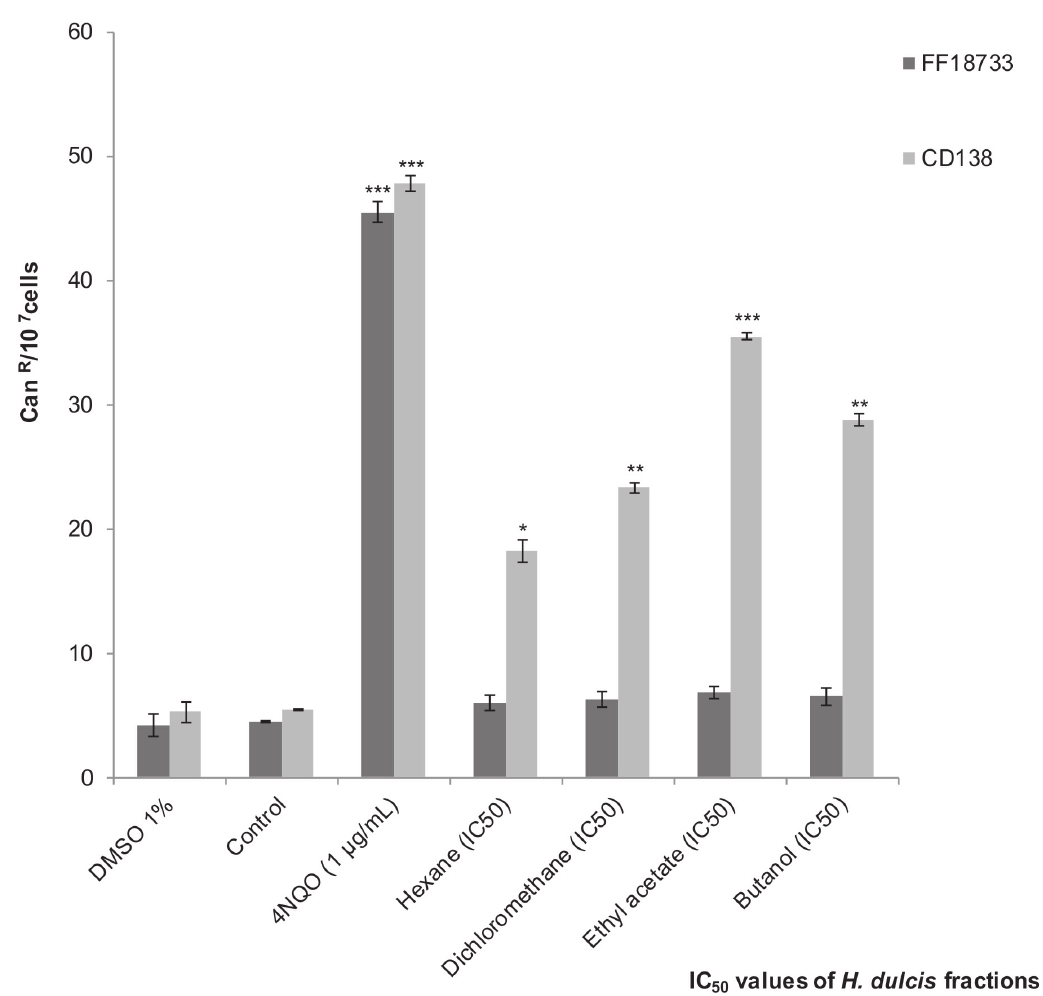
Figure 2. Spontaneous and exposure-induced mutagenesis frequency to fractions of H. dulcis ethanolic extract on S. cerevisiae strains, FF18733 and CD138. Evaluation after 48h of treatment with IC concentrations of H. dulcis ethanolic extract fractions *( p< 0.05) **( p < 0.01) *** ( p <0.001) compared to